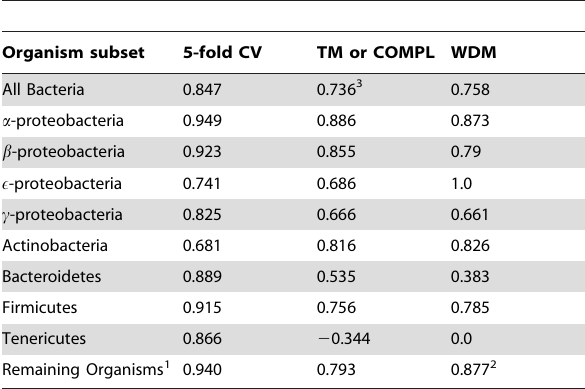
Table 2. MCC on cross validation and independent